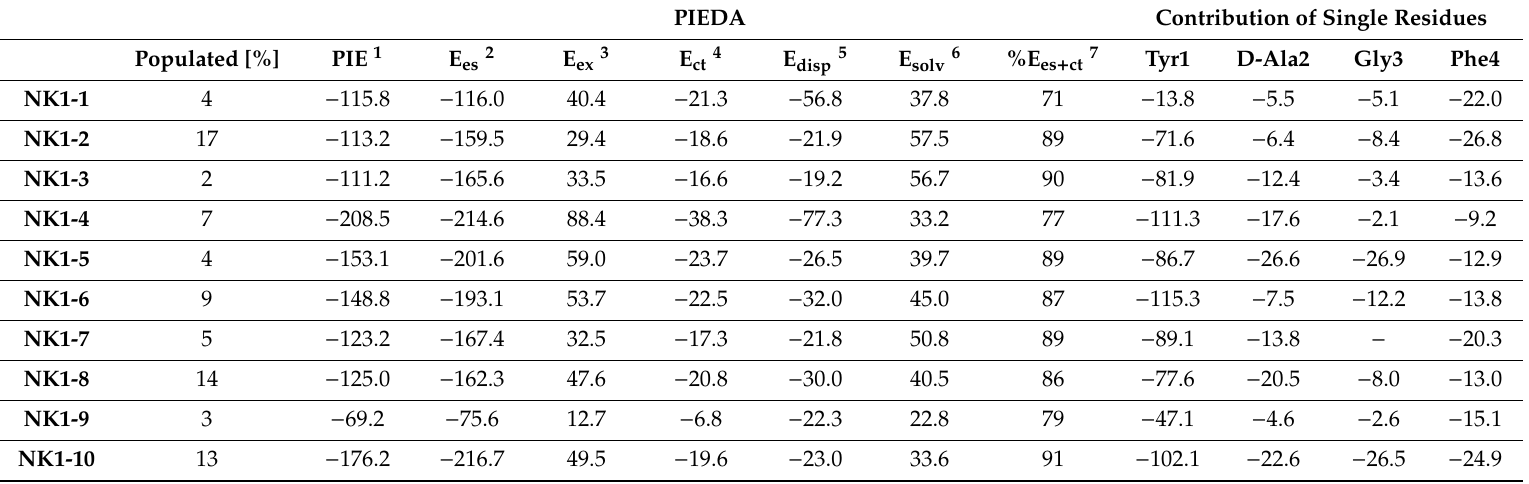
Table 7. Interaction energies (FMO PIEDA, kcal / mol) of the Tyr- d -Ala-Gly-Phe-fragment binding modes at